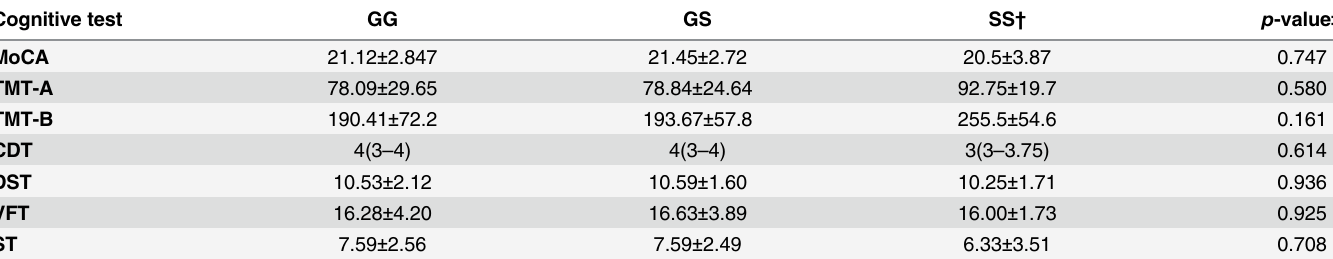
Table 5. Comparison of cognitive test scores in the MCI group according to the RAGE genotype. Cognitive